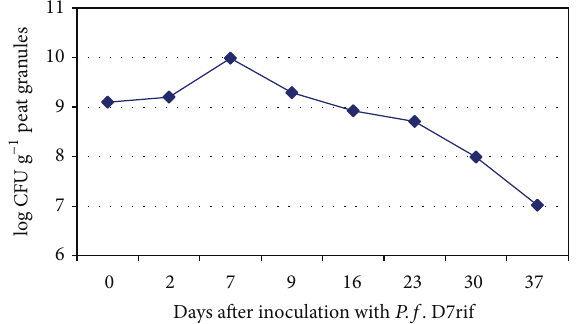
Figure 3: Recovery of P. fluorescens D7rif from peat granules after 37-day